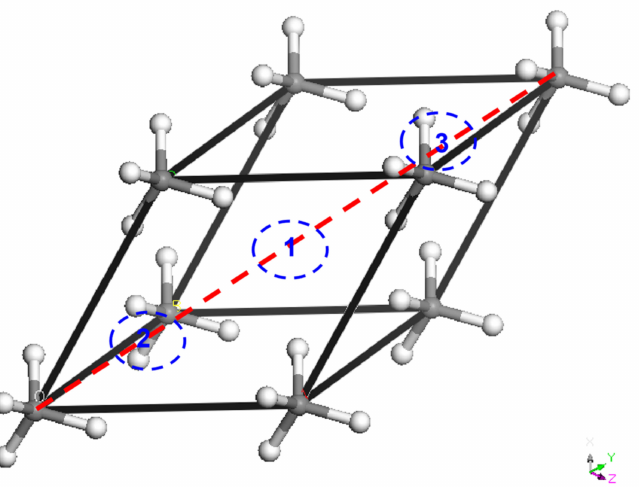
Figure 5. Schematic fcc primitive cell with CH 4 unit. 1, 2, and 3 denotes the location of atoms in fcc